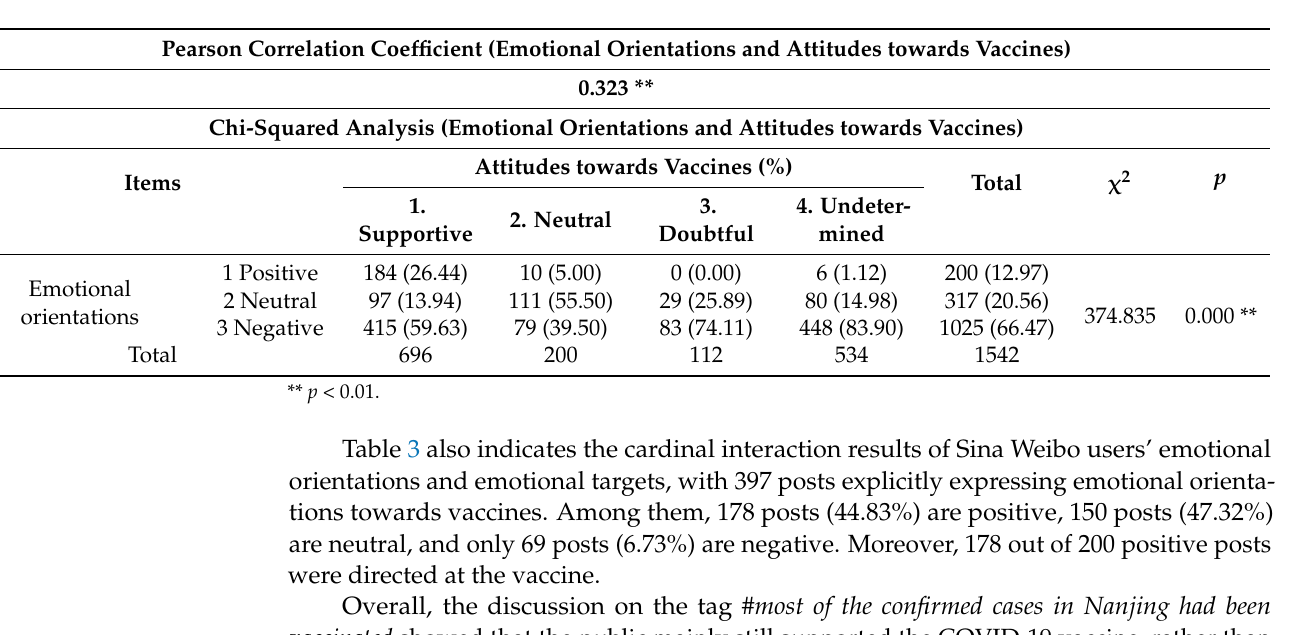
Table 4. Pearson correlation coefficient and Chi-squared analysis of emotional orientations and attitudes towards